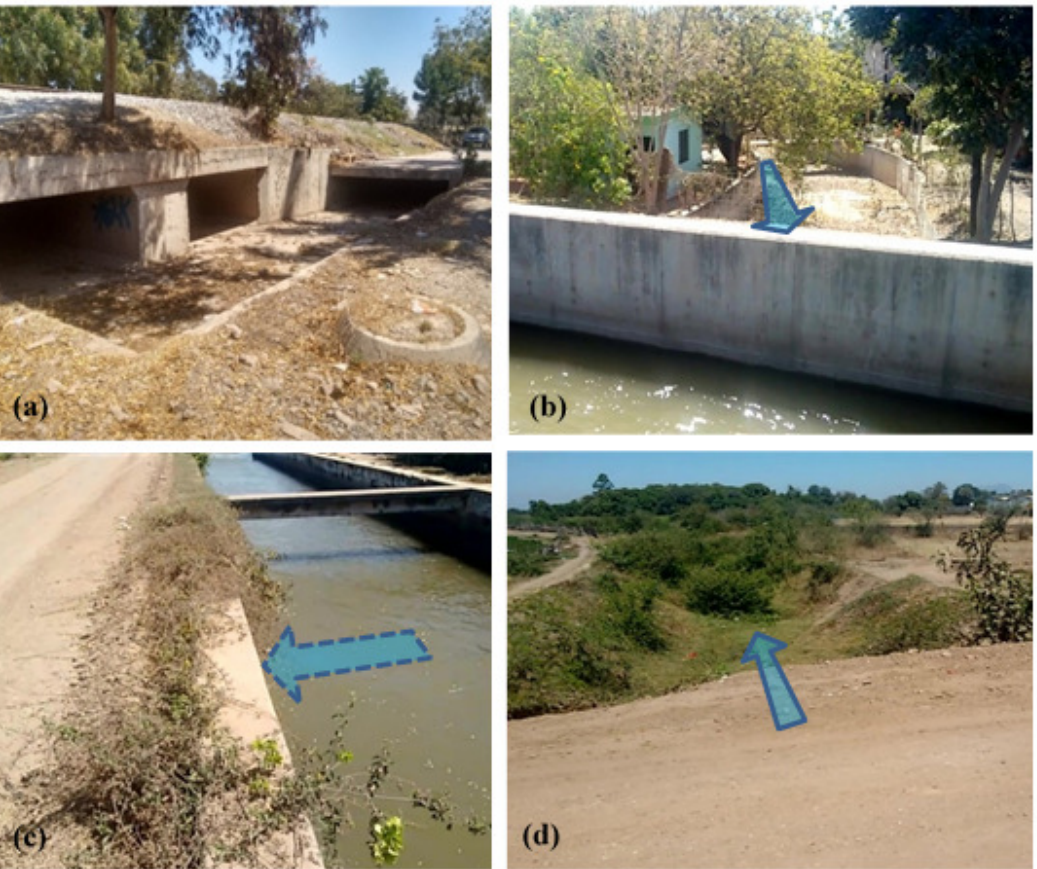
Figure 9. Evidence of changes in the drainage pattern due to agricultural and urban infrastructure. ( a ) Culvert drains runoff under a railroad. ( b ) Concrete-lined open ditch passes under a channel bridge. ( c ) Runoff drains to lateral channel. ( d ) Unlined ditch passing under a channel